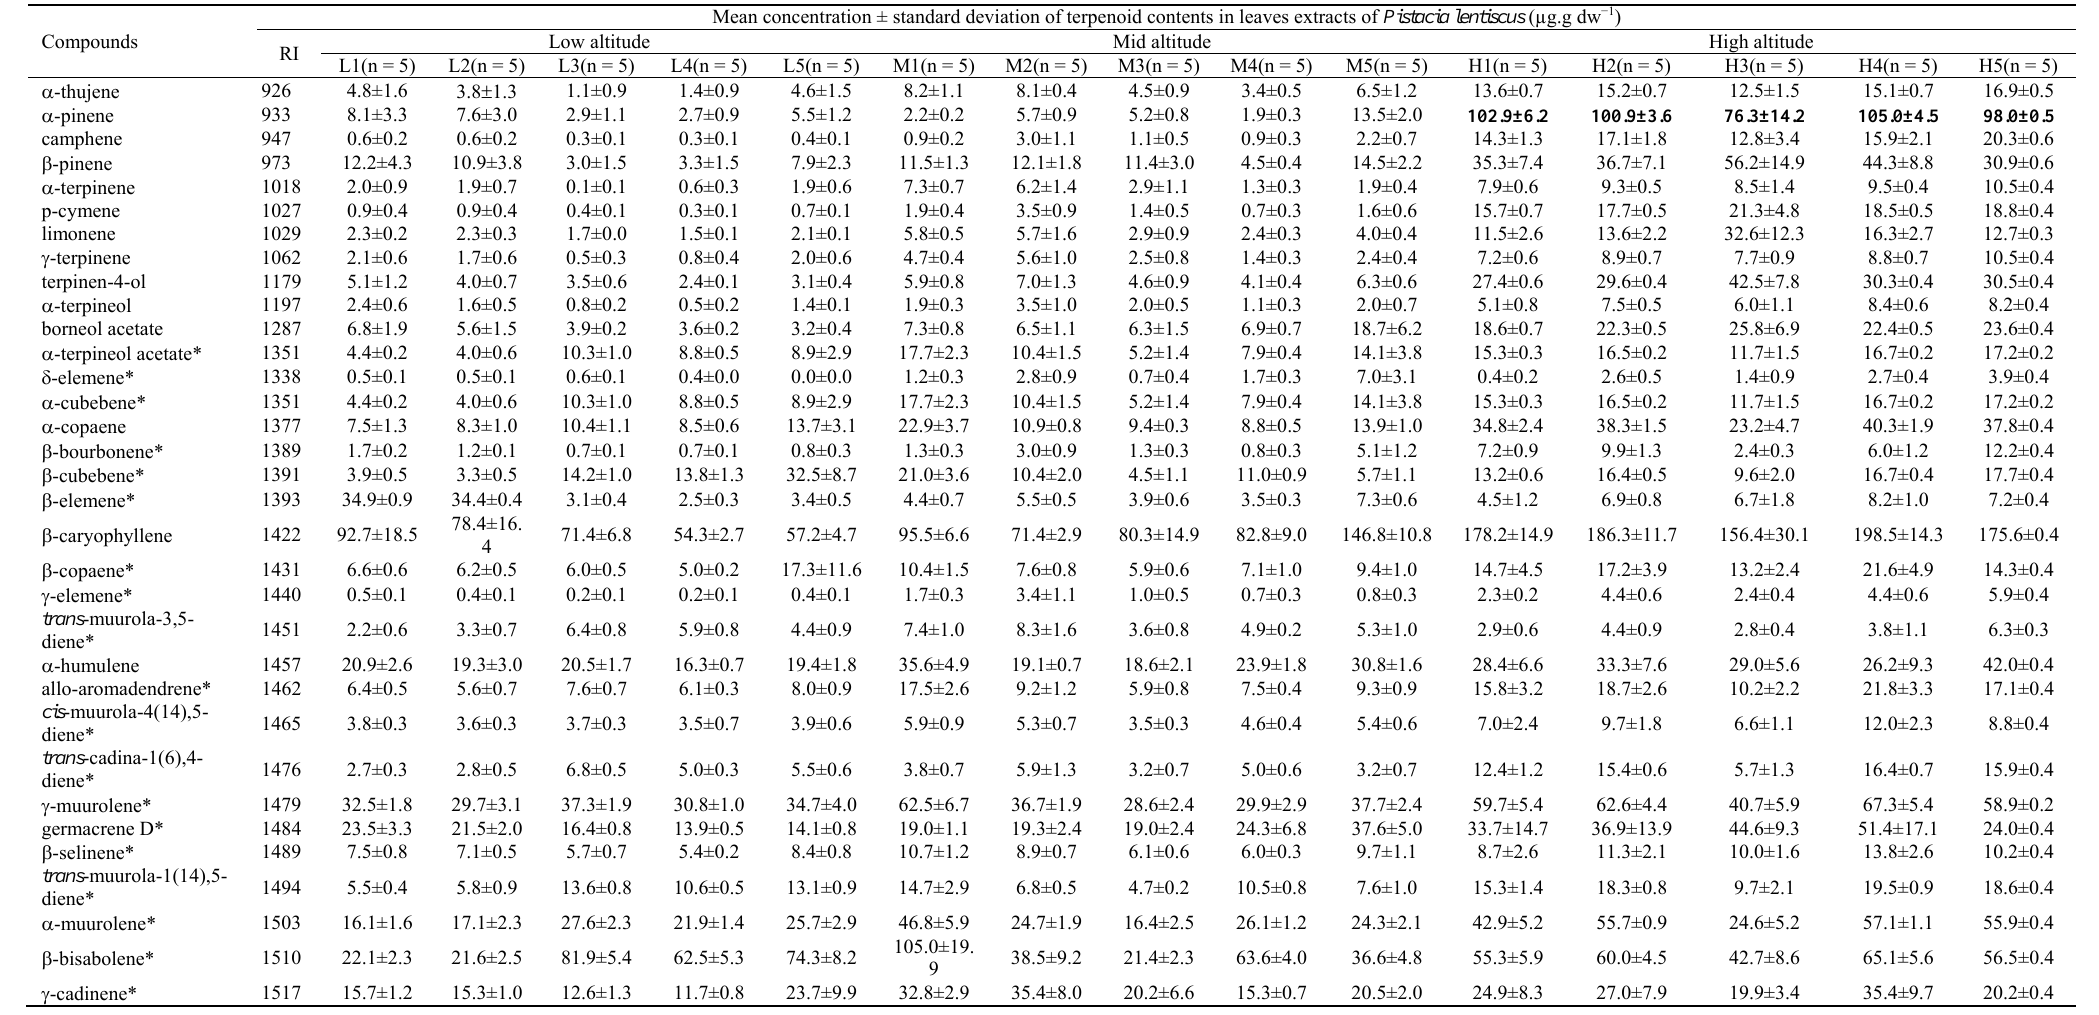
Table 1. Concentration of terpenoids (µg g –1 dw) found in female Pistacia lentiscus L. leaves from low, mid and high altitude sites in Algeria.